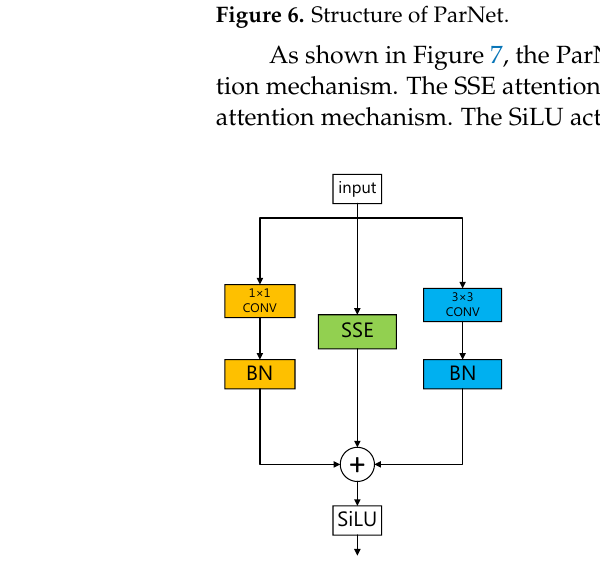
Figure 7. Structure of ParNet block.